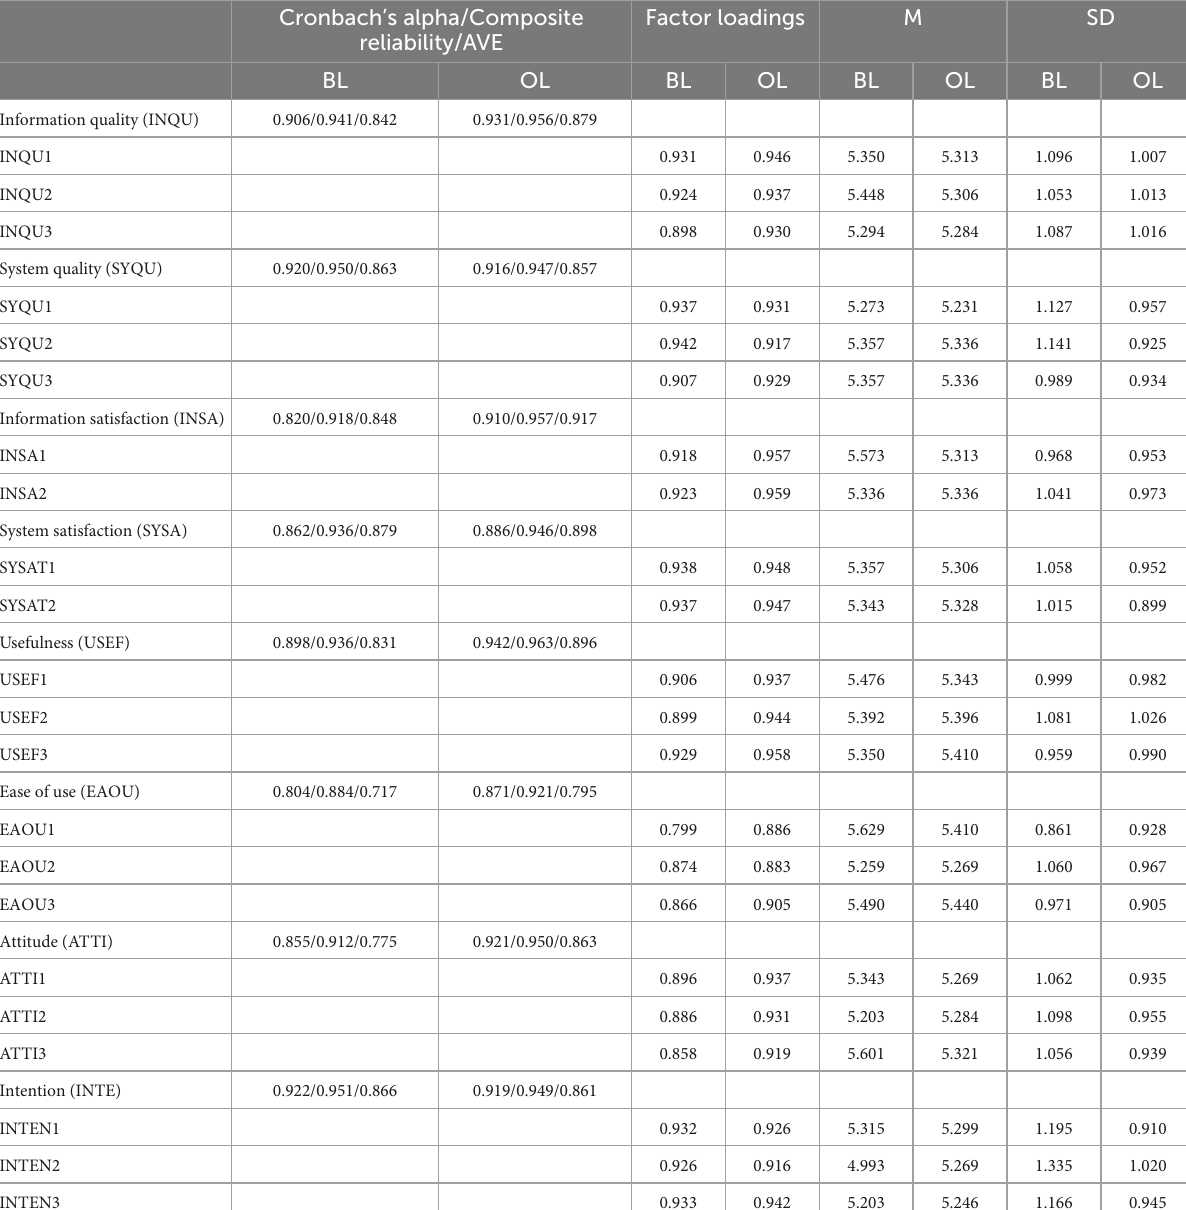
TABLE 1 Cronbach’s alpha, composite reliability, average variance extracted (AVE), factor loadings of the constructs and items in the research models of BL and OL. Cronbach’s alpha/Composite